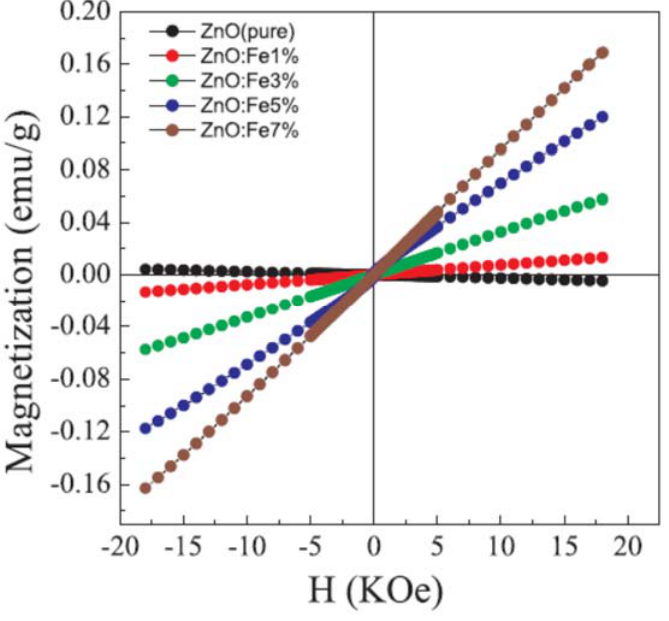
Figure 11. M-H hysteresis loops for Fe doped ZnO (The Figure was reproduced with copyright permission from reference